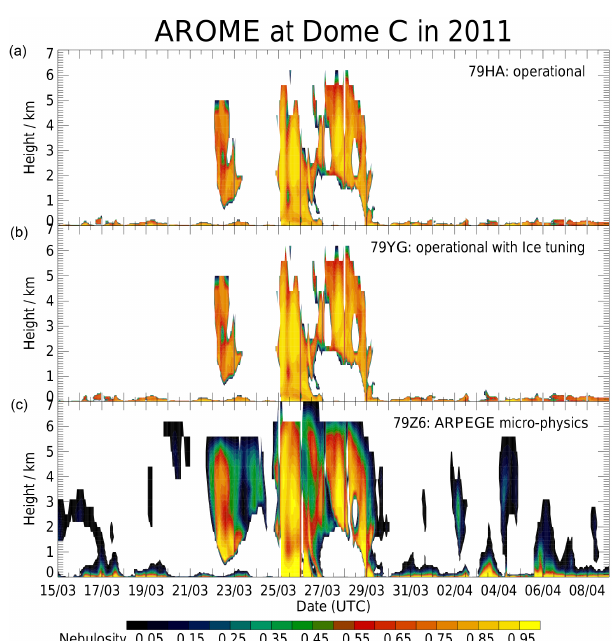
Figure 3. (a–c) Time evolution of nebulosity from 15 March to 8 April 2011 above Dome C as calculated by the mesoscale model AROME according to different runs: operational (a) , operational with ice tuning (b) and considering ARPEGE microphysics (c) . See the text for further information regarding the AROME runs.